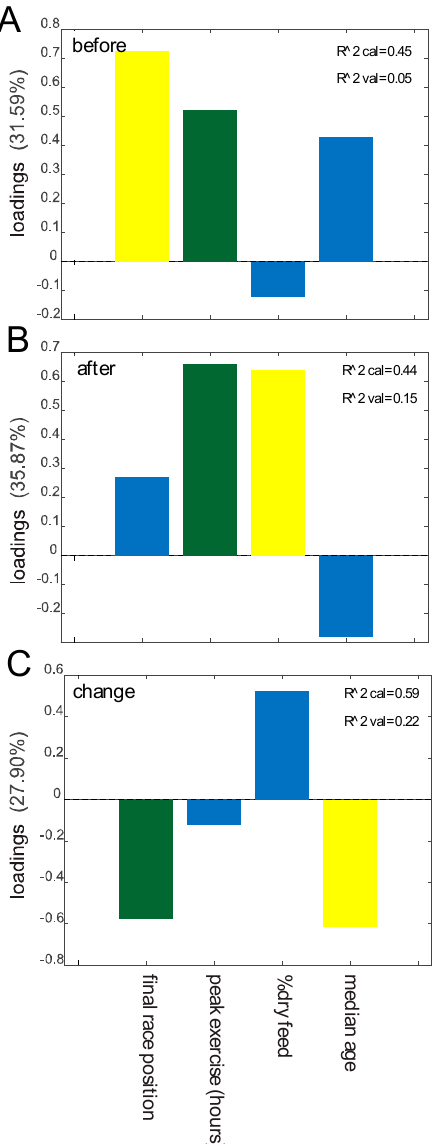
Figure 4. Prediction of dysbiosis based on metadata. Importance of predictors in the regression model for dysbiosis before the race ( A ), after the race ( B ), and changes from before to after the race ( C ). Predictors showing Spearman correlation p values <0.05 are colored green, p values <0.10 are yellow, and p values >0.10 are blue. Predictors with p values >0.10 in all cases are not included in the model.